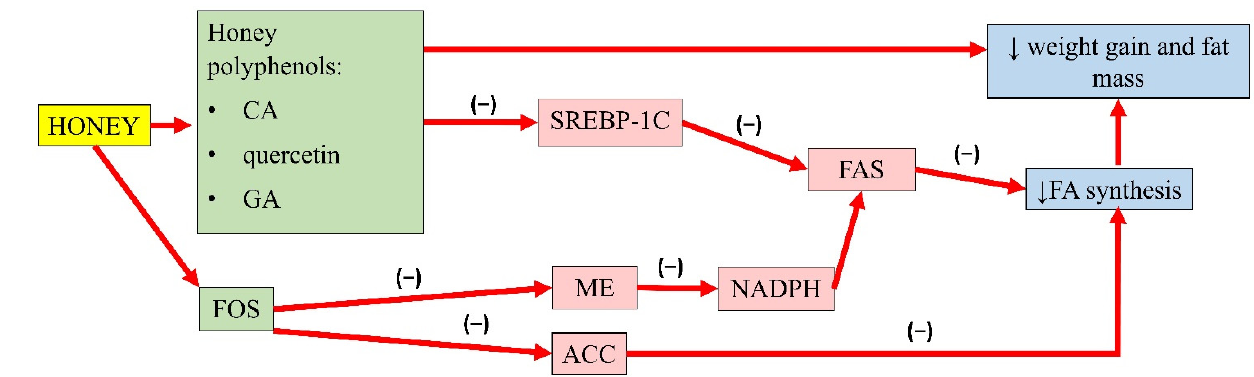
Figure 1. Summary of the antiobesity properties of honey. CA, caffeic acid; GA, gallic acid; FOS, fructo-oligosaccharides; SREBP-1C, sterol regulatory element-binding transcription factor 1C; ME, malic enzyme; ACC, acetyl-CoA carboxylase; FAS, fatty acid synthase; NADPH, nicotinamide adenine dinucleotide phosphate; FA, fatty acid; ( − ), inhibit; ↓ , reduce.